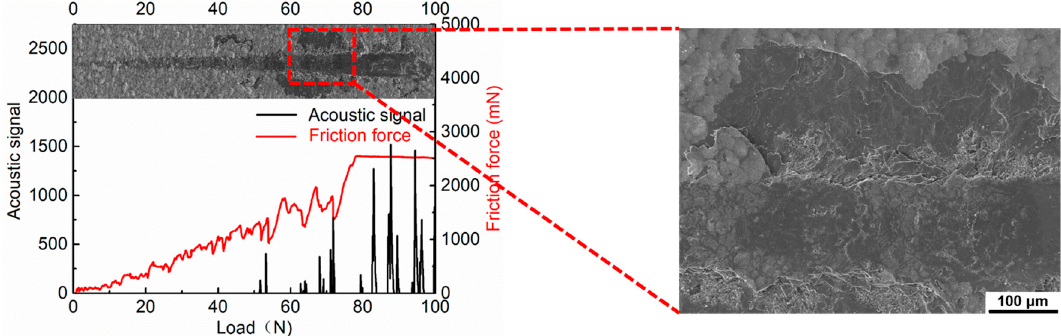
Figure 4. Scratch morphologies, acoustic emission spectra, and friction force curve and SEM image. Table 4. Mechanical test results of the coating.